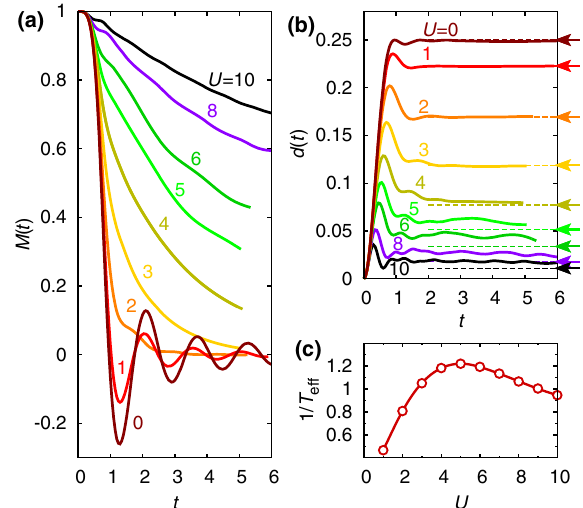
FIG. 1. (a) Time evolution of the order parameter M ð t Þ ¼ M = ½ 1 − 2 d ð t Þ(cid:4) for different values of the Coulomb repulsion stagg in the range U ¼ 0 to U ¼ 10 . (b) The double occupation d ð t Þ at the same values of U . Arrows indicate the double occupation in a thermalized state at the same total energy as the quenched state (as obtained from equilibrium DMFT, using a quantum Monte Carlo impurity solver [54]). All thermalized states are in the paramagnetic phase; the corresponding inverse temperature 1 =T is plotted in (c). eff by the probability P 1 for a site to be singly occupied, P t Þ ¼ 1 − 2 d ð t Þ . To test whether the system thermalizes 1 ð after the quench, we compare to an equilibrium state at the same internal energy (which is zero for the Néel state). The corresponding effective temperature T [Fig. 1(c)] lies eff above the Néel temperature T for all values of U [50]. N é el